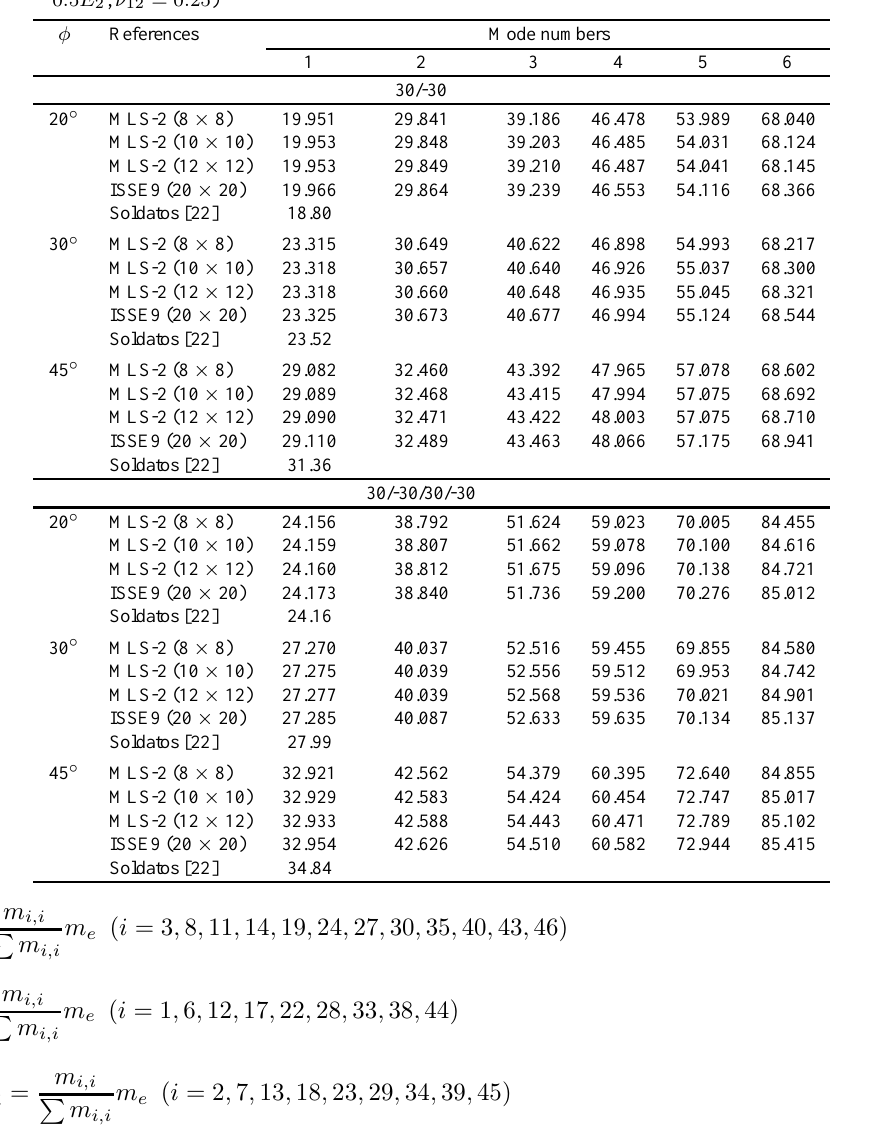
(cid:1) Table 5 ρ/E 2 h 2 ) of an angle-ply (30/-30/...) cylindrical shell